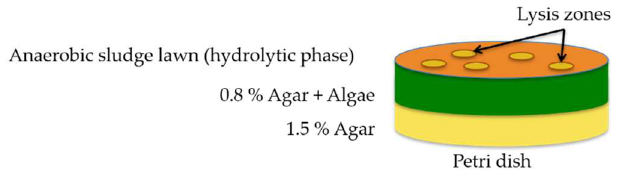
Figure 1. A double-layer-agar (DLA) technique to isolate algalytic